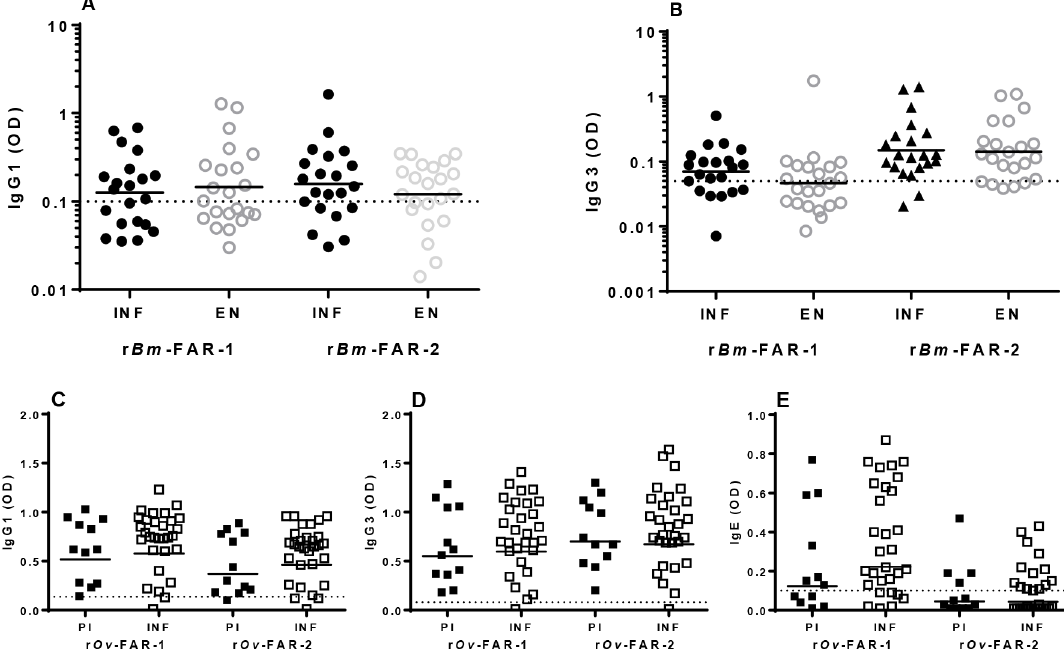
Fig 6. IgG1, IgG3 and IgE antibody responses against Bm- FARs and Ov -FARs in human populations living in filariae endemic regions. Anti-r Bm -FAR-1 and r Bm -FAR-2 IgG1 ( A ) and IgG3 ( B ) responses in children that were infected (INF) or uninfected (EN) who lived in Cook Islands, an endemic region for lymphatic filariasis. Anti-r Ov -FAR-1 and r Ov -FAR-2 IgG1 ( C ), IgG3 ( D ) and IgE (E) responses in putatively immune (PI) and infected (INF) individuals who lived in onchocerciasis highly endemic area in Cameroon. The ODs obtained with a pool of 10 control normal human sera samples at 1:100 (IgG1 and IgG3) or 1:50 (IgE) dilution were used to calculate the cutoff for each assay based on mean OD ± 3X SD (dotted line): 0.1 for anti-r Bm -FAR-1 and anti-r Bm -FAR-2 IgG1; 0.05 for anti-r Bm -FAR-1 anti-r Bm -FAR-2 IgG3; 0.135 for anti-r Ov -FAR-1 and anti-r Ov -FAR-2 IgG1; 0.08 for anti-r Ov -FAR-1 and anti- r Ov -FAR-2 IgG3; and 0.1 for anti-r Ov -FAR-1 and anti-r Ov -FAR-2 IgE. The cutoff was used to calculate the number of responders, individual having IgG1, IgG3 or IgE OD values more than mean + 3X SD of normal human sera. Analysis was done using the Mann- Whitney test.